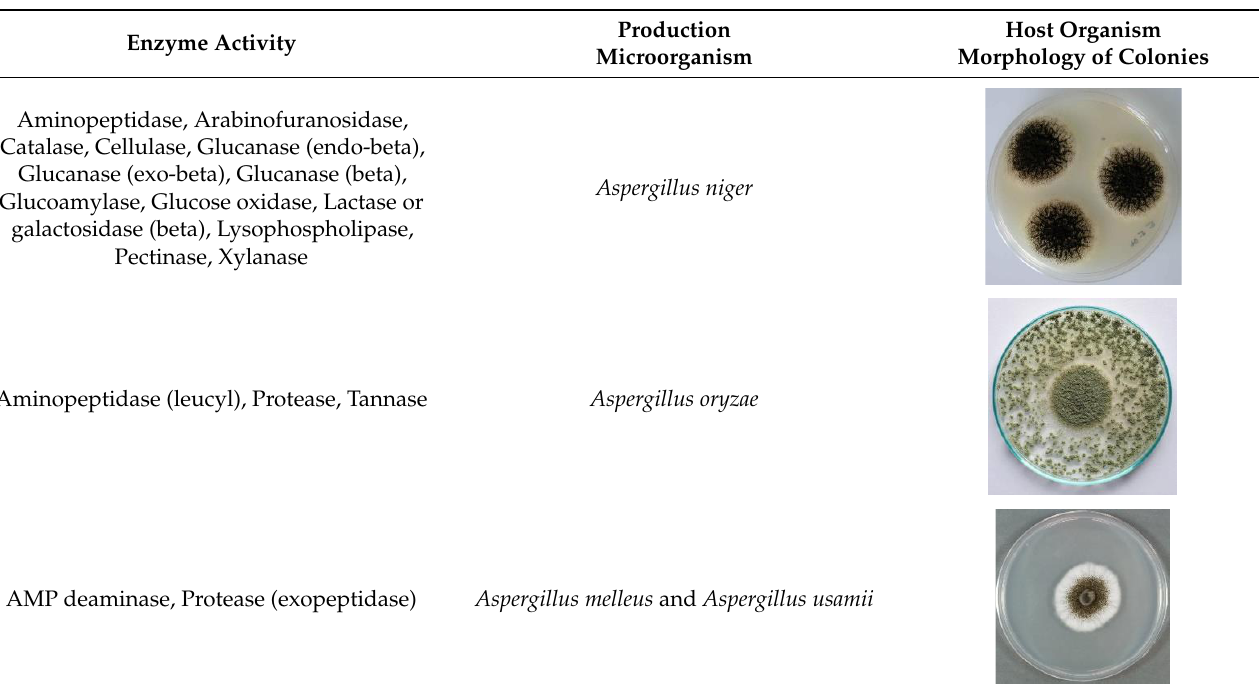
Table 1. List of approved enzyme activity for use as processing aids in food in Europe. For each product, the fungal or bacterial origin of the host organism is shown (colonies formed on Petri dishes in Potato-Dextrose Agar-PDA). Adapted from [13].